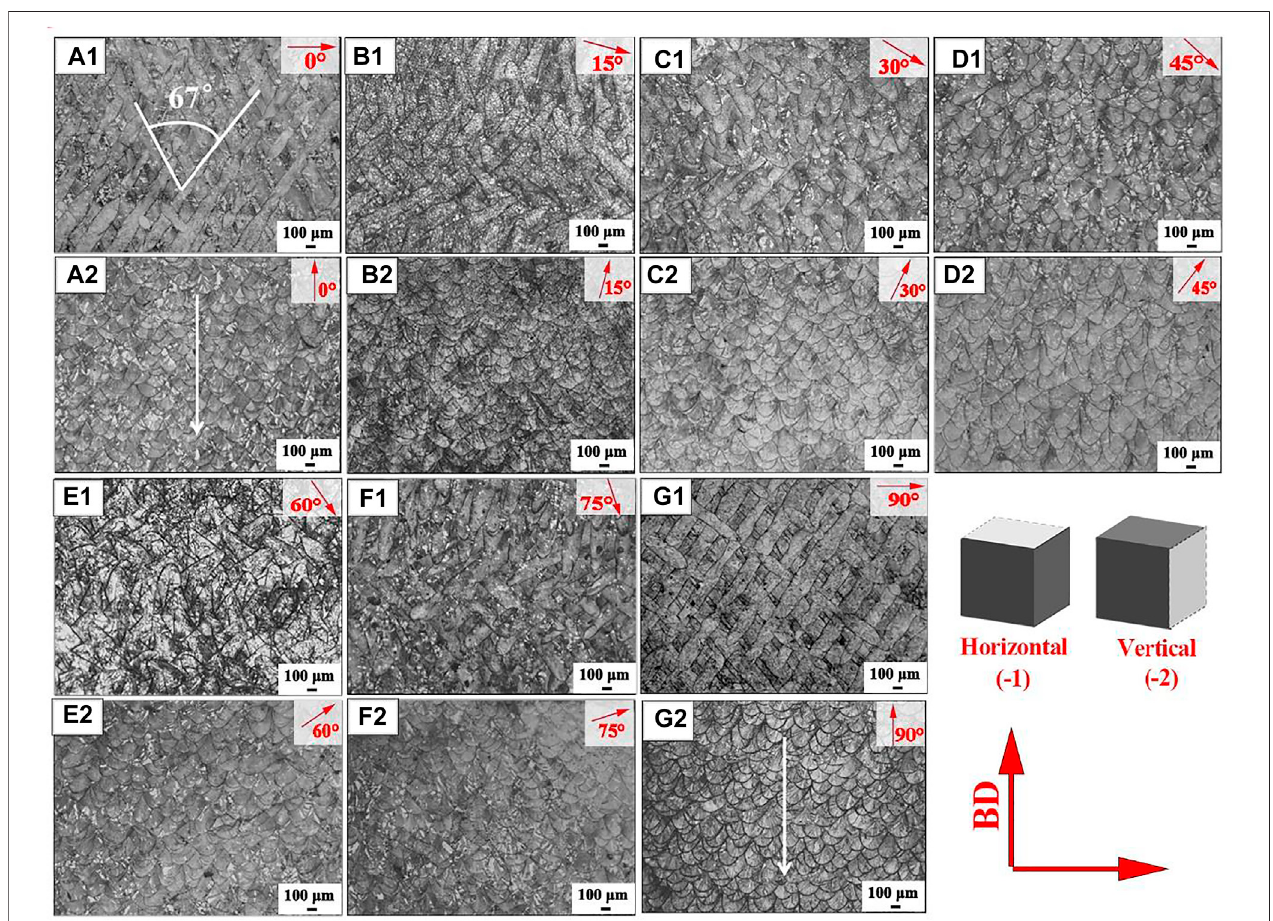
FIGURE 2 | OM images of SLM-processed 316L SS from different angles relative to the build substrate: (a 1 -g 1 ) cross section and (a 2 -g 2 ) longitudinal section.